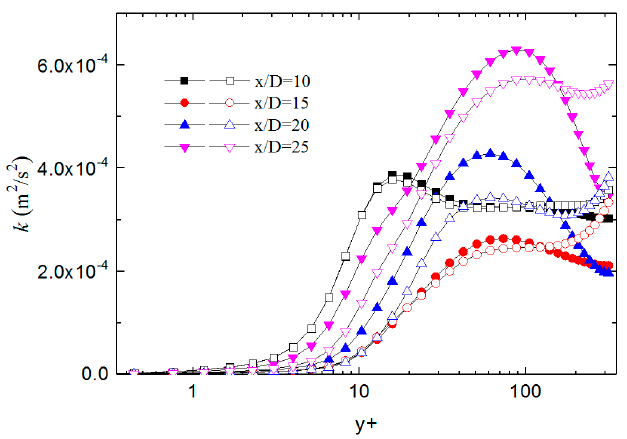
Figure 10. Comparison of turbulent kinetic energy in different location (Solid: C2; Hollow: D2).